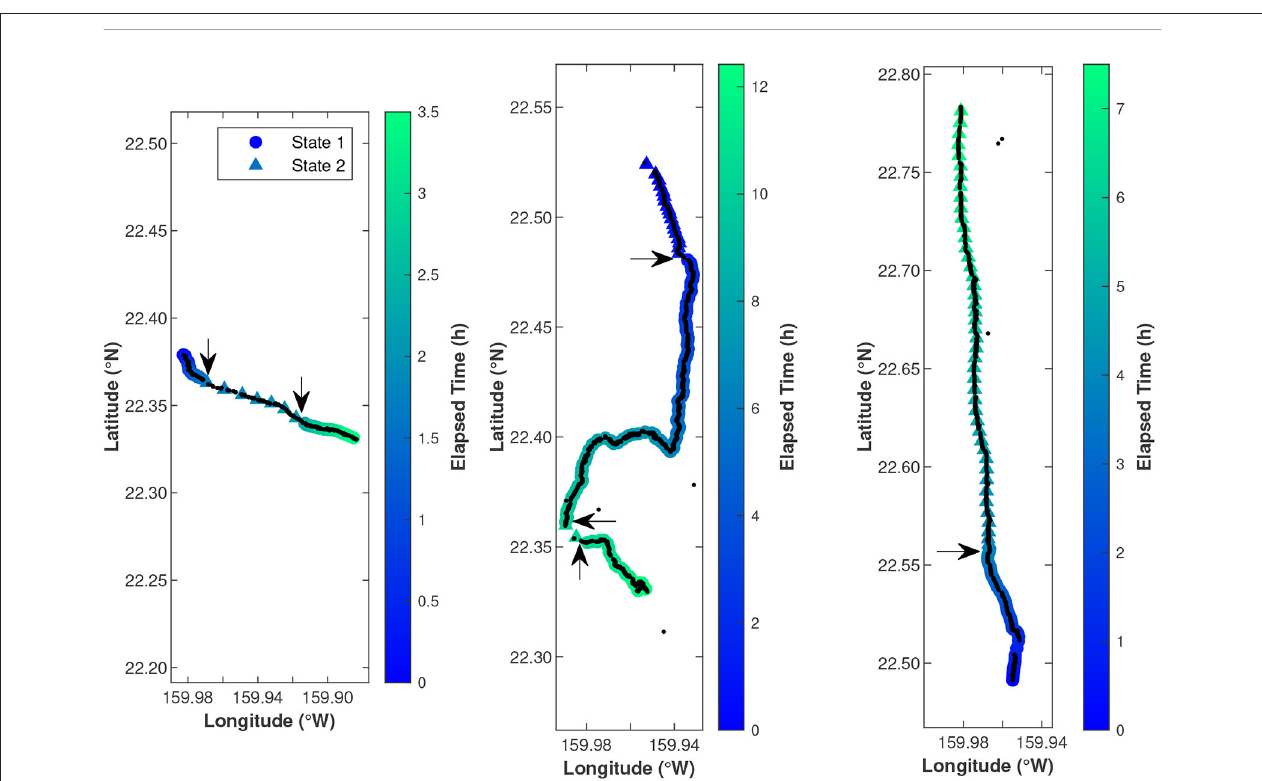
FIGURE 2 | These three example fin whale tracks show one black dot at the location of every localized note. Colored circles and triangles show the estimated whale locations on 5-min intervals with circles representing the slower, less directed State 1 and triangles representing the faster, more directed State 2. The states were determined by hidden Markov models. Arrows indicate the locations of state changes. A few spurious localizations can be seen in black, but were eliminated from tracks during the CRAWL track smoothing process. Color indicates time since the start of the track. Note that the elapsed time is different for each track. The latitude ticks are every 0.05 ◦ and the longitude ticks are every 0.02 ◦ . From left to right, these tracks started at 13 January 2012 07:11 UTC and transited 11.5 km, 24 January 2015 06:09 UTC and transited 27.6 km, and 20 March 2015 12:15 UTC and transited 32.5 km. These are the same tracks plotted in Figures 5 and 8 of Helble et al. (2020).